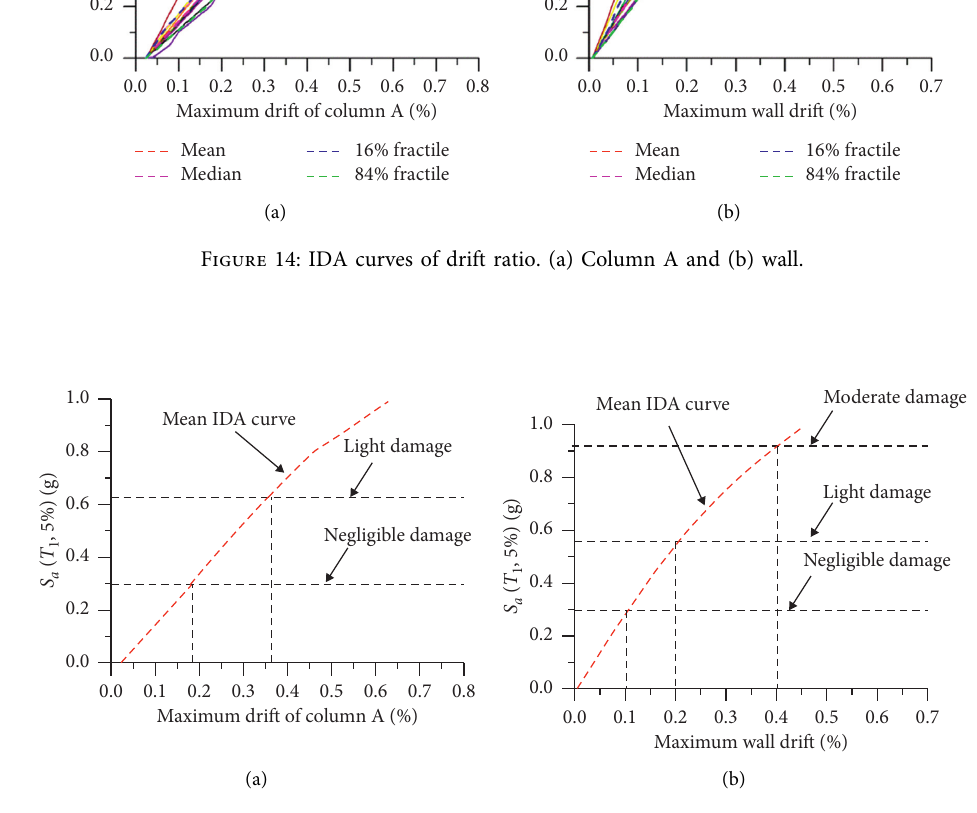
Figure 15: Mean IDA curves of drift ratio. (a) Column A and (b)